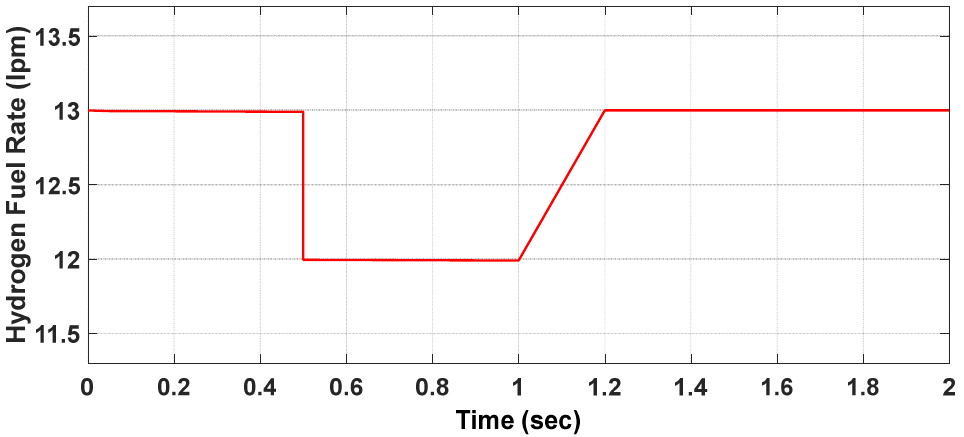
Figure 4. Test Pattern of HFR (lpm) used for Simulation Analysis.